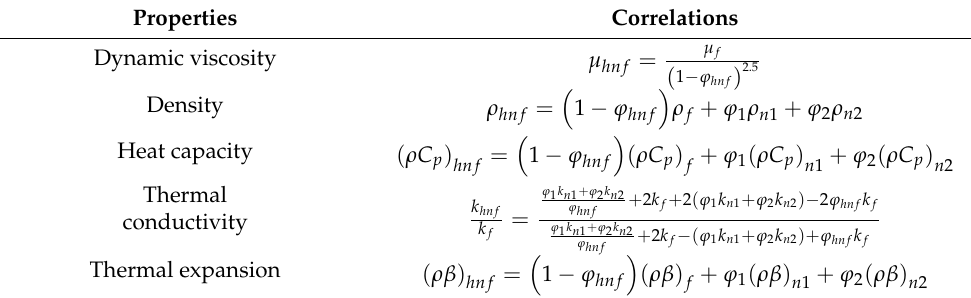
Table 2. Thermophysical properties of hybrid